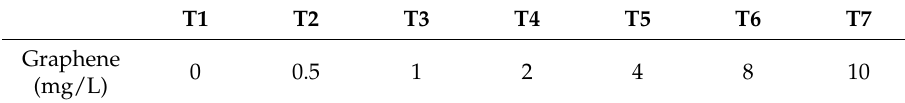
Table 1. Graphene concentration in each